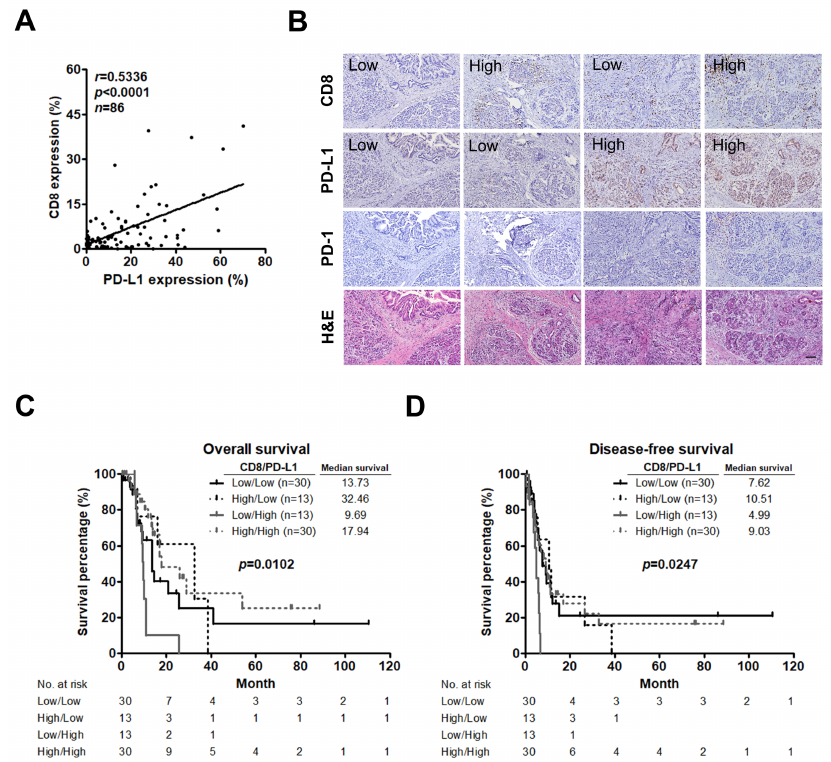
Figure 3. Low CD8 + T cell infiltration and high PD-L1 expression significantly stratifies patient survival. ( A ) Correlation analysis between percent CD8 + T cells and PD-L1 expression per patient. Pearson correlation coe ffi cient (r) and significance level ( p value) is shown for correlation. ( B ) IHC staining of CD8 + T cells infiltration ( upper panel ), PD-L1 expression ( second panel ), PD-1 expression ( third panel ), and H&E staining ( lower panel ) in the same tumor tissues. Original magnification, 20 × ; scale bars, 100 µ m. ( C , D ) Kaplan-Meier curves for OS ( C ) and DFS ( D ) of patients stratified based on CD8 + T cells infiltration and PD-L1 expression. P values determined using the log-rank test. OS, overall survival; DFS, disease-free